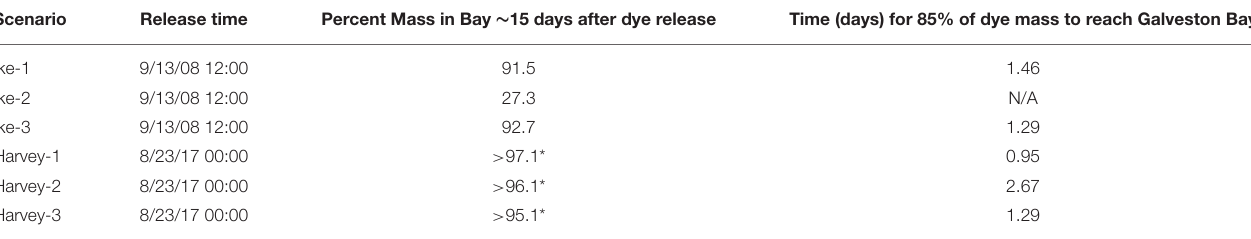
TABLE 4 | Results for the Ike and Harvey spill scenarios with their corresponding release times, final percentage of mass in GB, and time lapse for 85% of the dye mass leaving the model domain.